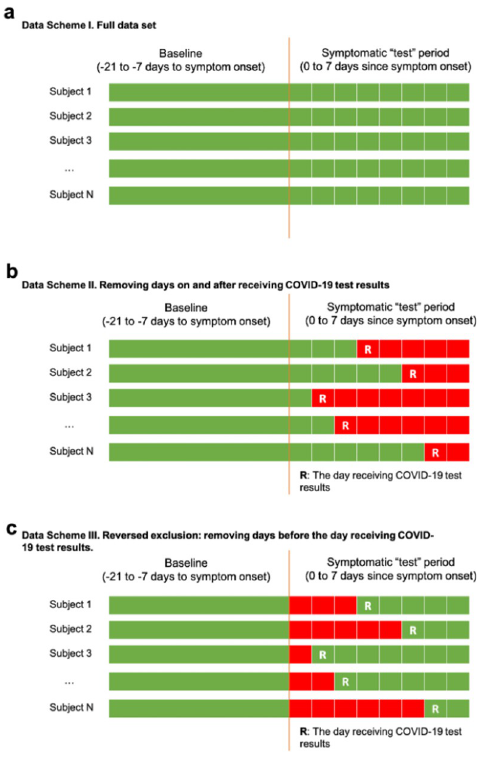
Fig 1. Data schemes. a-c , green: included data; red: excluded data; R: the day receiving test results: ( a ) include all data; ( b ) exclude data on and after the day receiving test results; ( c ) exclude data before the day receiving test results since symptom onset. Ninety-two subjects (87.6%) received their results within the symptomatic period (0 to 7 days after symptom onset).